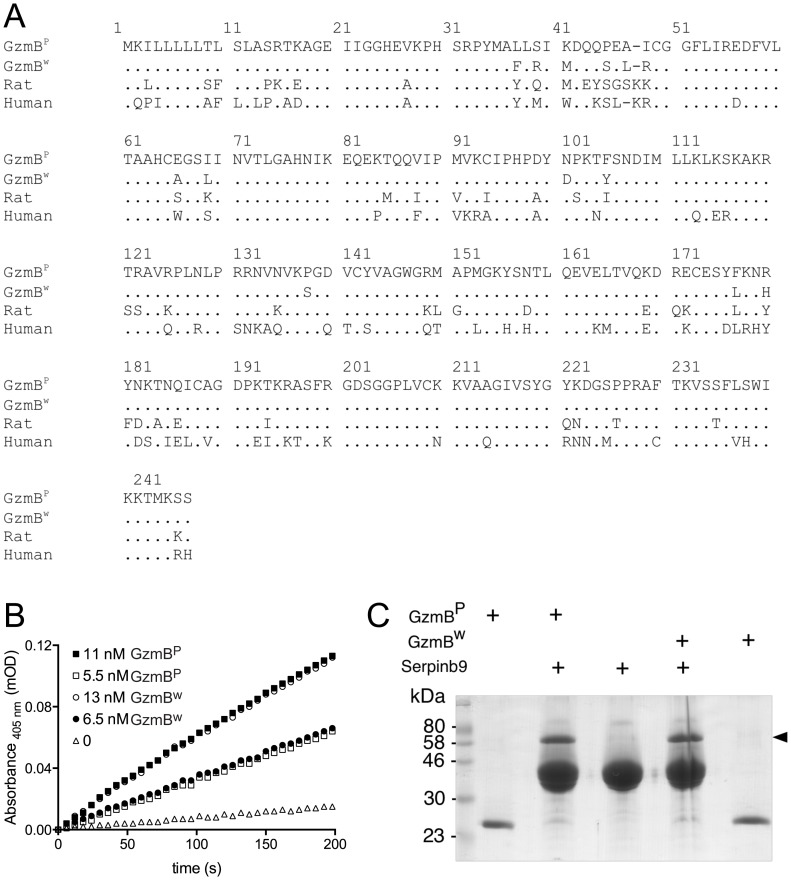
GzmBW and GzmBP have distinct substrate preferences.(A) Predicted amino acid sequences of the p (common inbred) and w (wild) alleles of mouse GzmB. A comparison with the sequences of human (RAH allele) and rat GzmB is shown, commencing with the 18-residue leader peptide and the activation peptide GE which is trimmed in the cytotoxic granules by cathepsin C or H. The mature protein commences with the tetrapeptide IIGG. Single amino acid code is used, with dots denoting identical amino acid at the same position. (B) Progress curves of recombinant granzymes at indicated concentrations cleaving the peptide thioester substrate Boc-Ala-Ala-Asp (AAD)-SBzl. (C) Interaction of recombinant granzymes with Serpinb9. One µg of granzyme was incubated with 10 µg serpin and complex formation assessed by 10% SDS-PAGE with Coomassie Blue staining. Note that all the granzyme shifts into complex (arrowed), indicating fully active preparations.